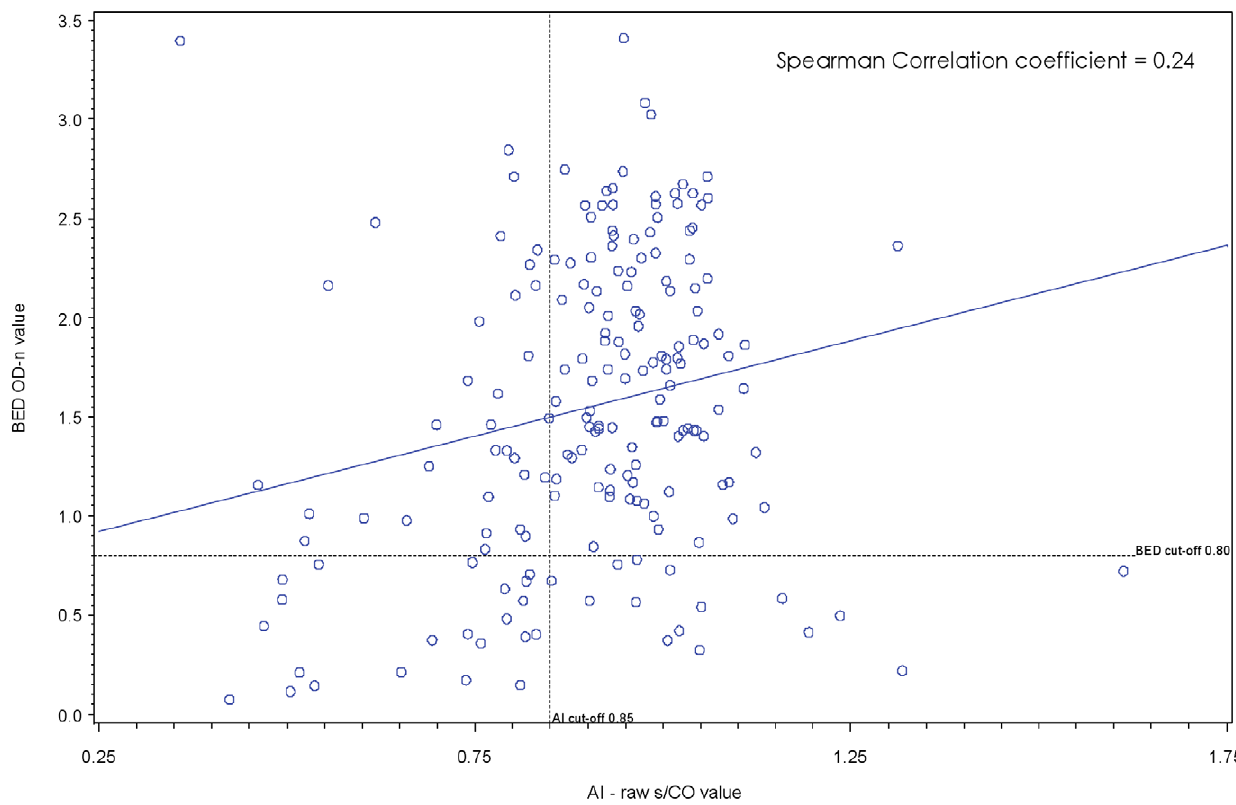
Figure 2. Correlation of results on BED-CEIA and AxSYM Avidity Index for recent HIV infection, Cross-sectional sample (N=190).